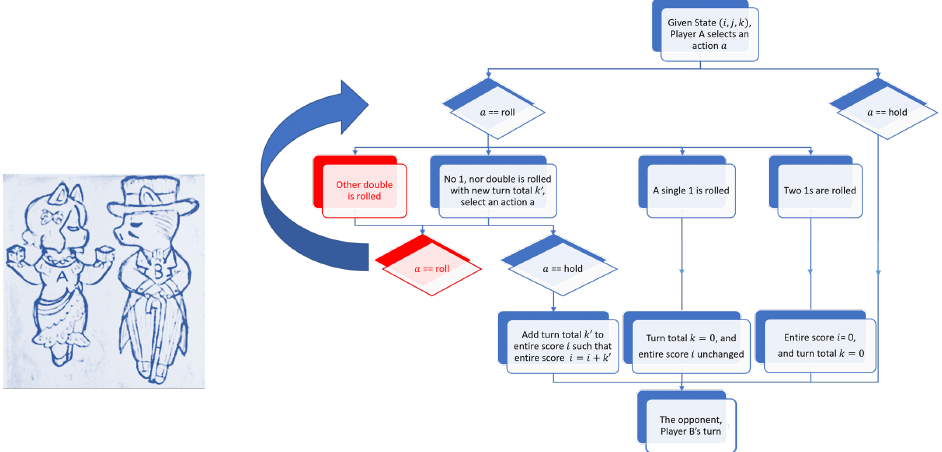
Figure 7. Rules of play for the “Double Trouble” variation of the two-dice Pig